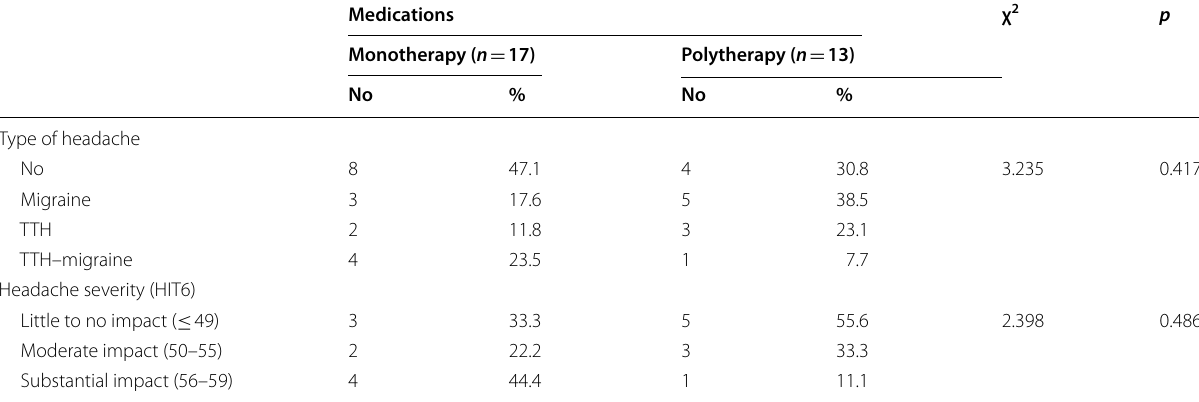
Table 5 Relation of headache type and severity to the type of medications used in epileptic group ( n